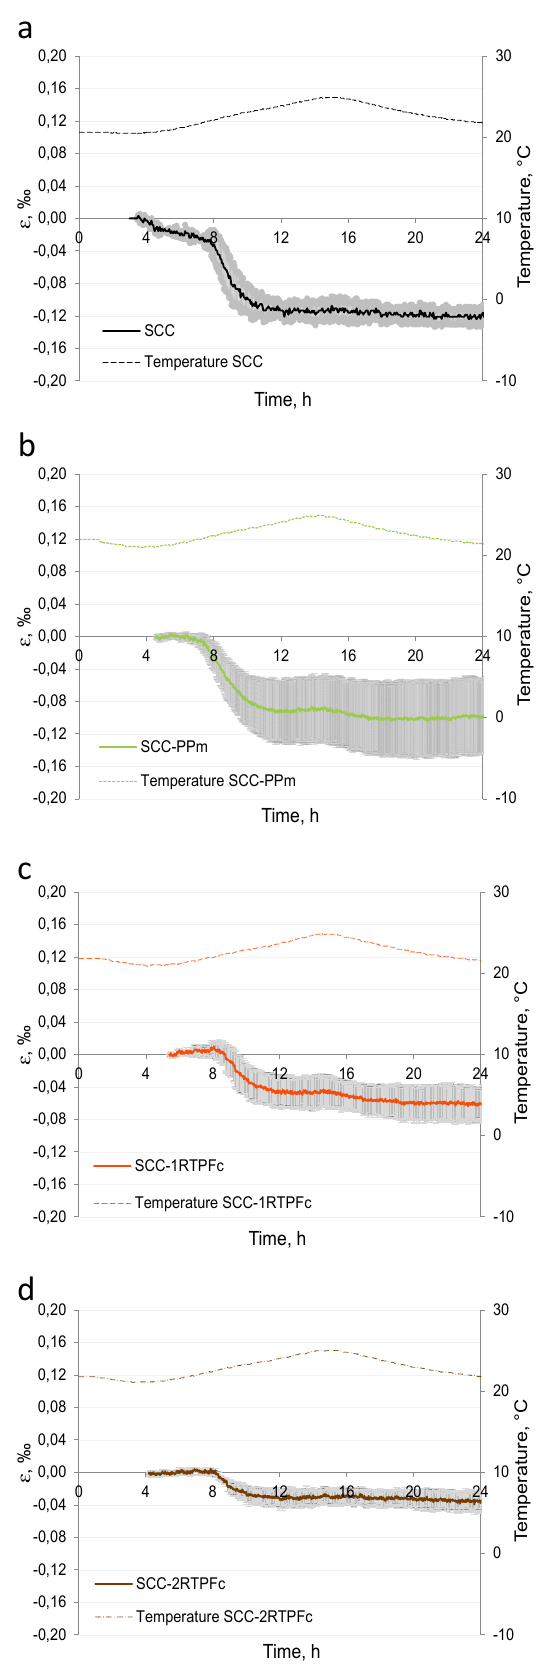
Figure 9. Average results of the early age deformation measurements: a) SCC; b) SCC ‐ PPm; c) SCC ‐ 1RTPFc; d) SCC ‐